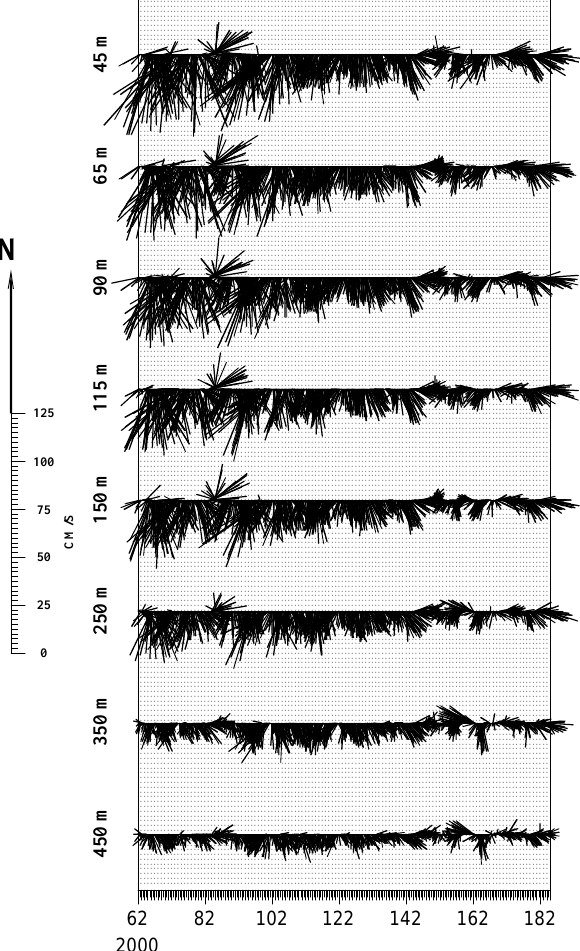
Fig. 7. Stick diagram of ADCP currents at different levels for the